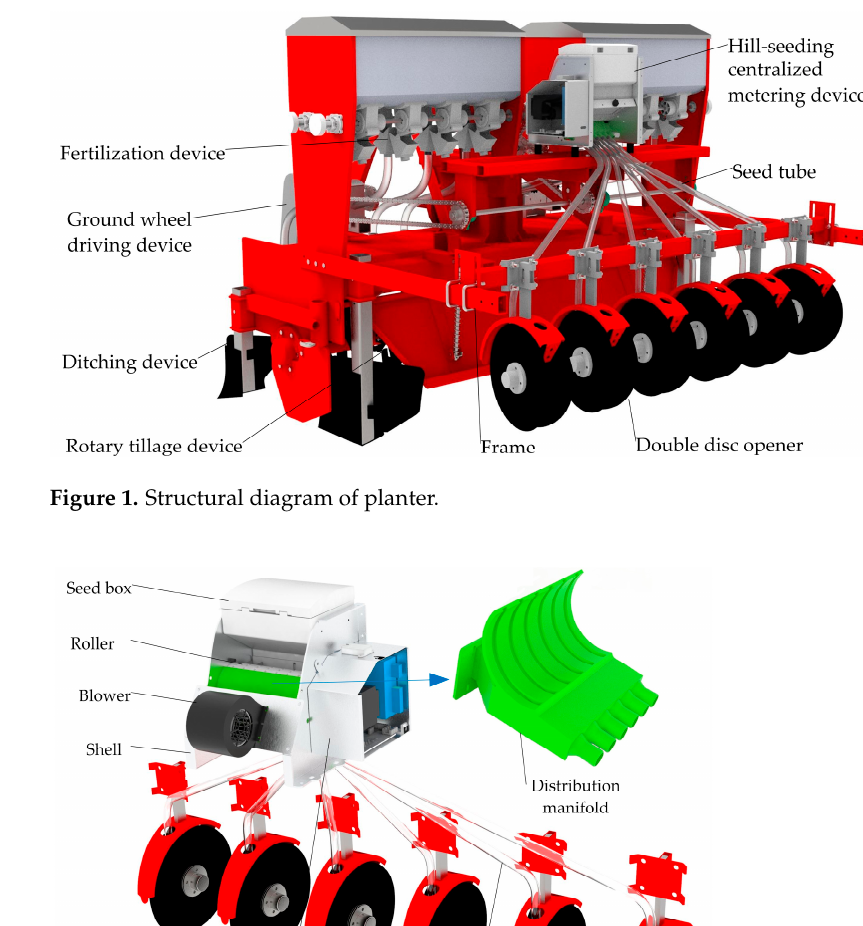
Figure 2. Structural diagram of seeding system.